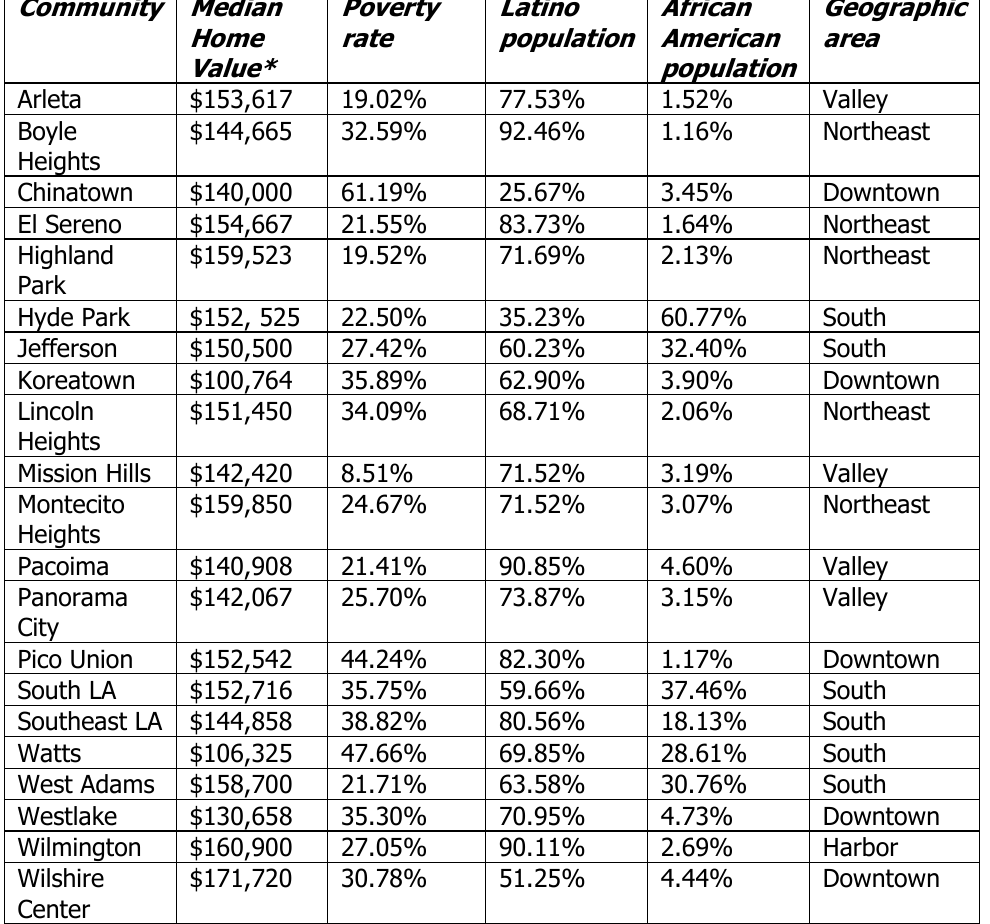
Income indicators and racial/ethnic composition of selected LA Communities in low TCC